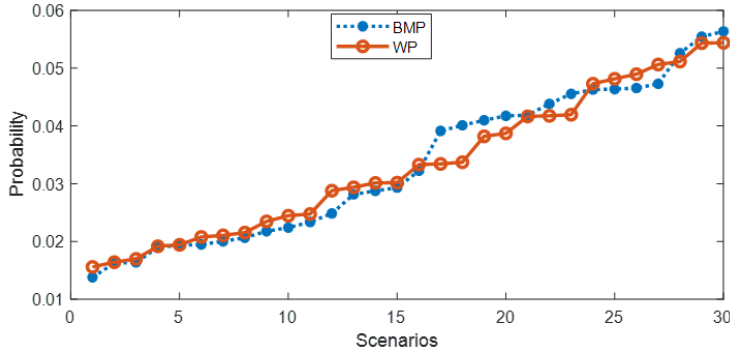
Figure 8. The probability of BMP and WP for 30 alternative